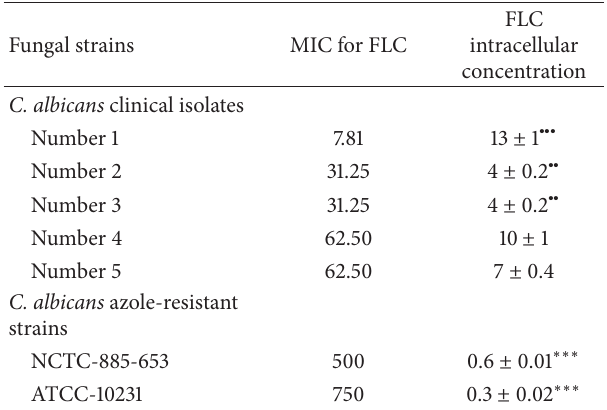
Table 4: MIC values for FLC and FLC intracellular concentration ( 𝜇 g/mL) of C. albicans azole-resistant strains and five different C. albicans clinical isolates ¶